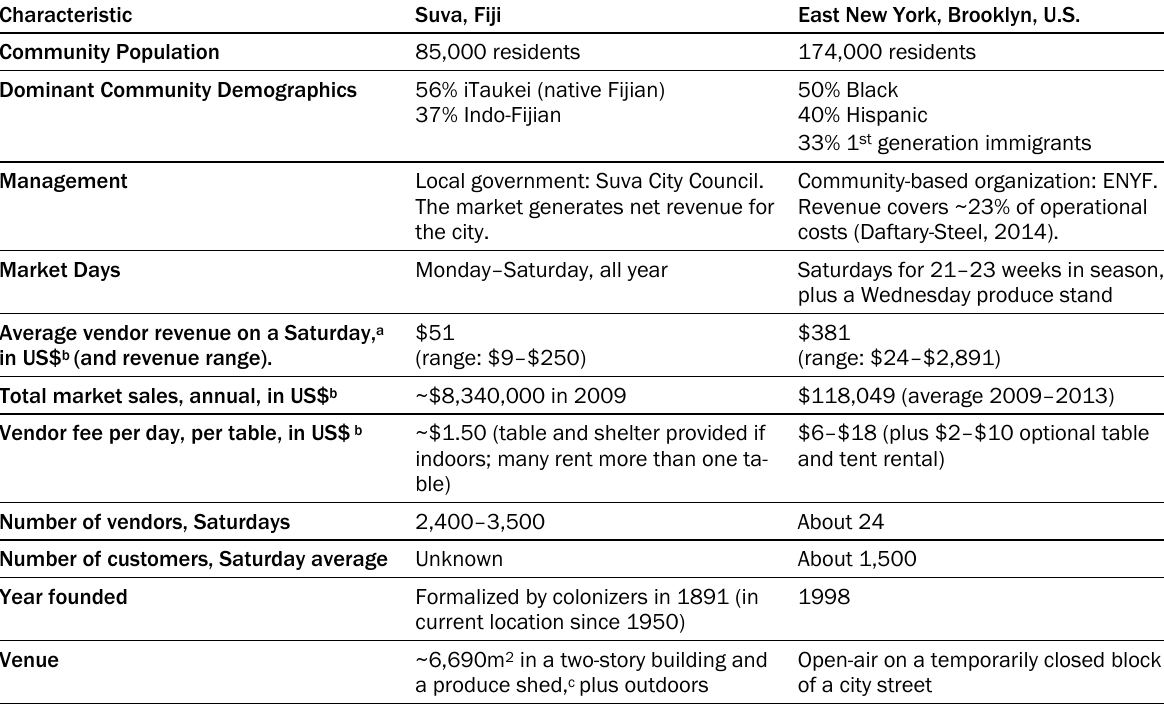
Table 2. Descriptive Summary of Two Community Contexts and Their